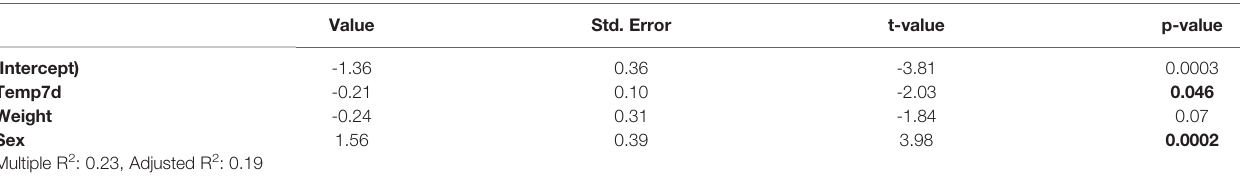
TABLE 3 | Association of free T4 and outdoor temperature. Association of Free T4 and Outdoor Temperature Model: fT4 ~ Temp7d + Weight +